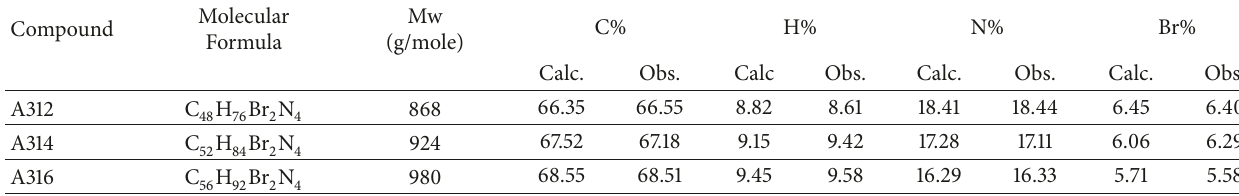
Figure 2: 1 H-NMR spectra of A312. Table 1: Elemental analysis of A312, A314, and